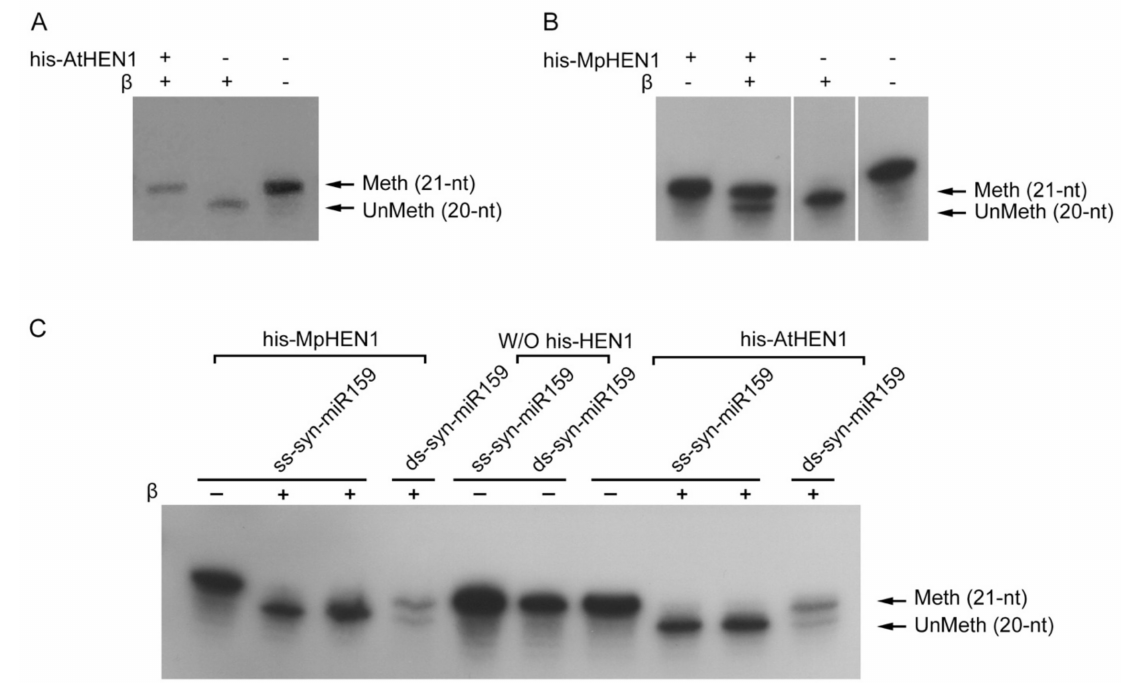
Figure 2. In vitro methylation activity and substrate specificity for his-AtHEN1 and his-MpHEN1. The his-AtHEN1 ( A ) and his-MpHEN1 ( B ). In vitro methyltransferase activity assay. Meth, the 21-nt position represents the methylated miRNA. UnMeth, the 20-nt position represents the unmethylated miRNA. ( C ) The substrate specificity evaluation of AtHEN1 and